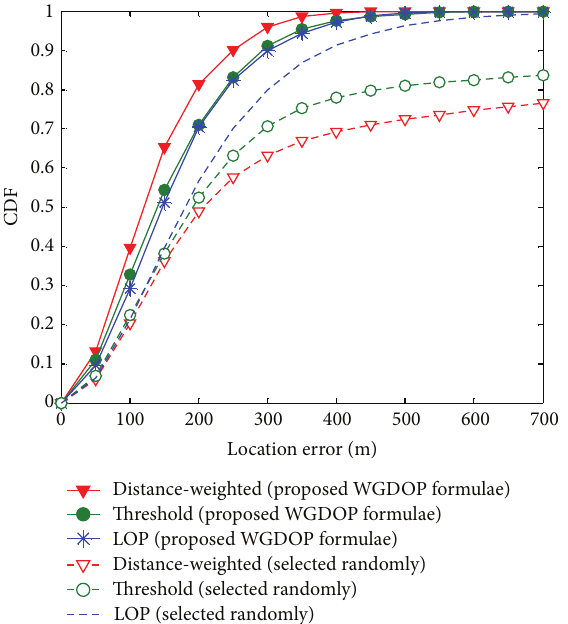
Figure 4: CDFs of location error of the subset with proposed minimum WGDOP formulae, and the subset selected four BSs randomly (Type